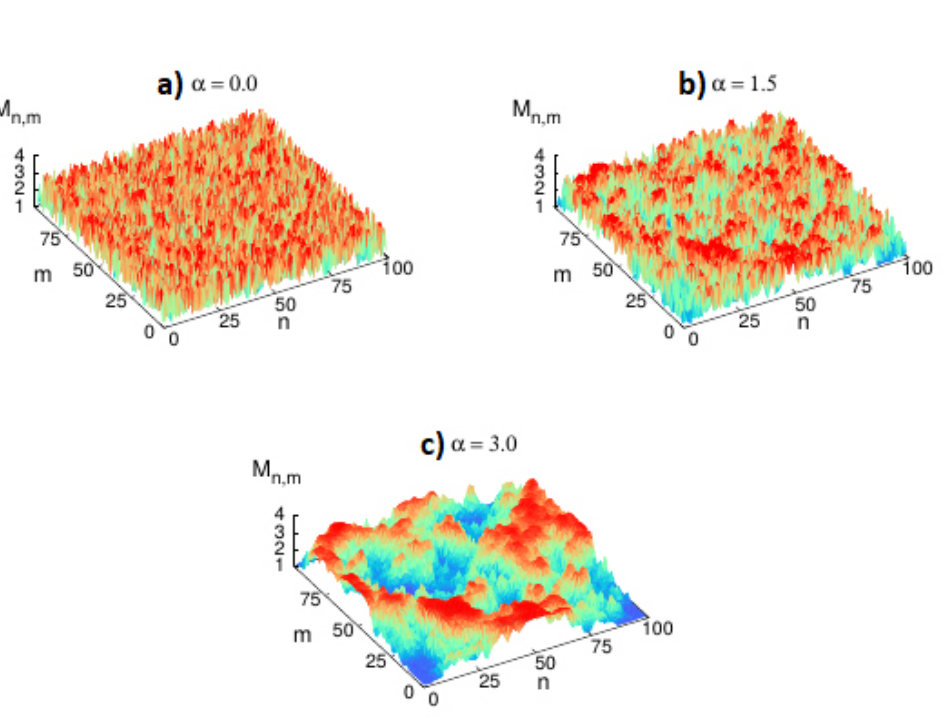
Figure 1 - M n,m × n × m for L = N = 100 and α = a) 0 , b) 1.5 and c) 3 . We observe that as α is increased, masses’ distribution becomes smoother due to the presence of long-range correlations.